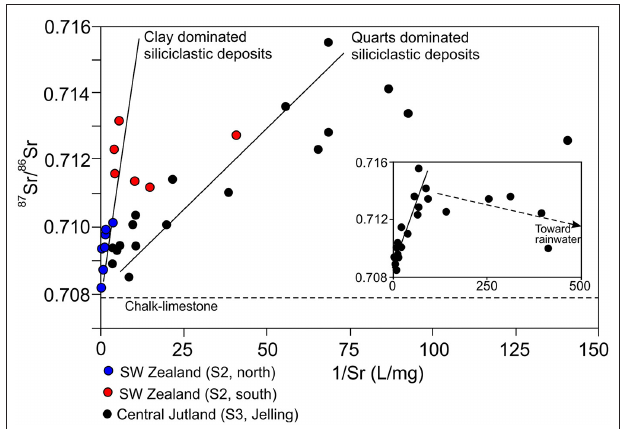
FIGURE 9 | Strontium isotope ratio vs. inverse strontium concentration for pristine samples from SW Zealand (study area S2, blue and red dots) and central Jutland (study area S3, black dots). Samples from SW Zealand define a mixing line with steep slope (high Sr concentration) between a calcareous end-member dominant in the northern samples and a siliciclastic end-member dominant in the southern samples. Samples from central Jutland define a mixing line with a shallower slope (lower Sr concentration) indicating different compositions of the siliciclastic end-members in the two study areas. A few samples, particularly in Jutland (insert), fall off the mixing line and trend toward dilution with rainwater [ 87 Sr/ 86 Sr = 0.7092 and 1/Sr = 1,000–10,000 (Frei and Frei, 2011; Thomsen and Andreasen,